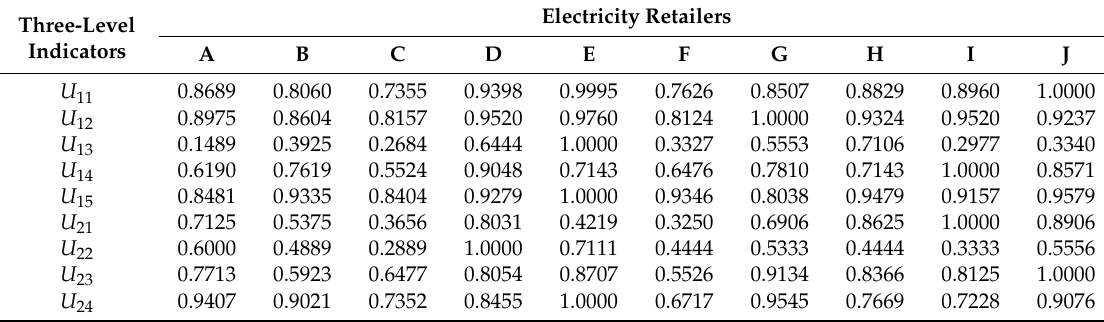
Table 4. Normalized data of energy saving and emission reduction effects evaluation indicators of electricity retailers.